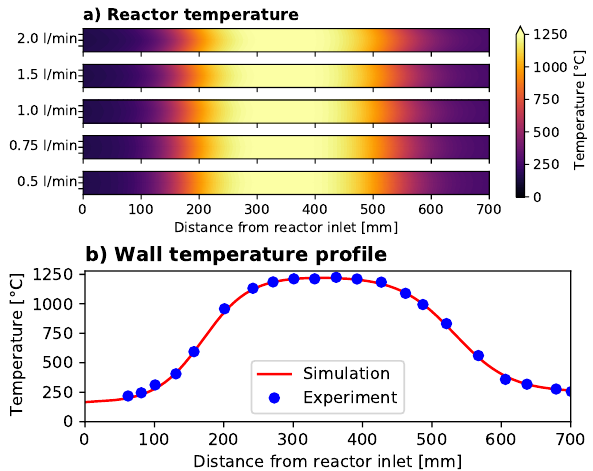
Figure 11. Wall temperature of the reactor. The red line is the smooth model temperature and the blue circles are the experimental measurements from Hoecker et al.